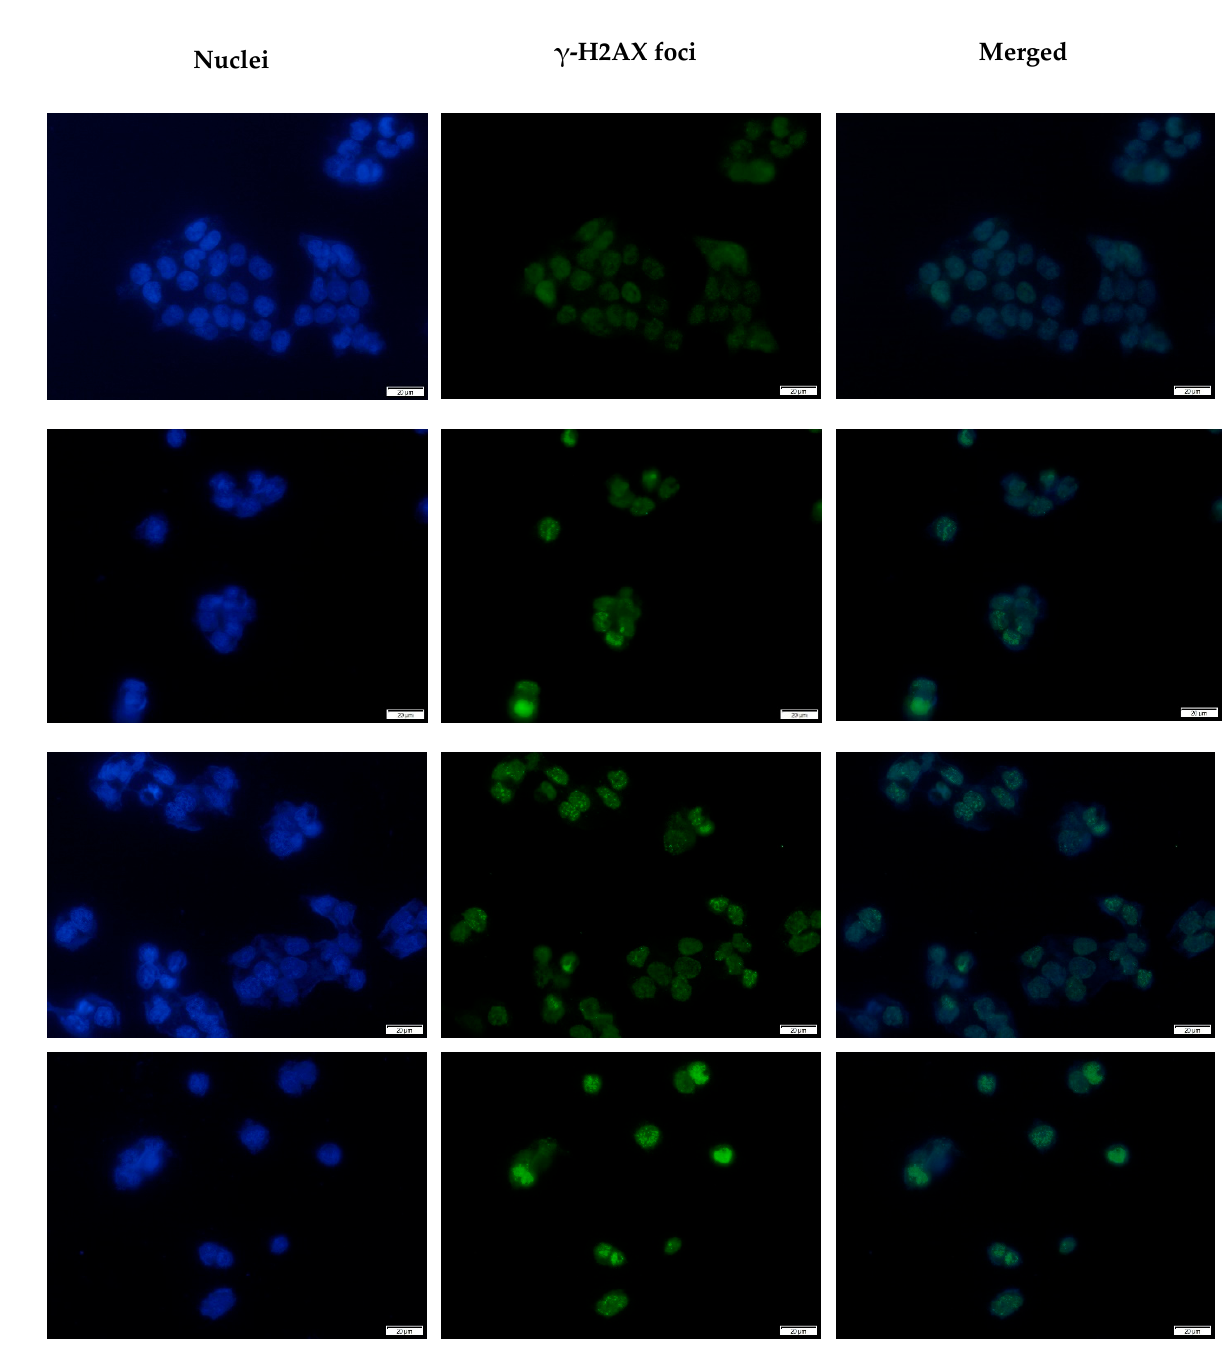
Figure 6. Exemplary images of γ -H2AX foci in HCT 116 cells after 24 h treatment with MM com- pounds in the concentrations equal to their 2 × IC 50 values; nuclear DNA stained with DAPI (blue); γ -H2AX foci (green). The scale bar is 20 μ m.